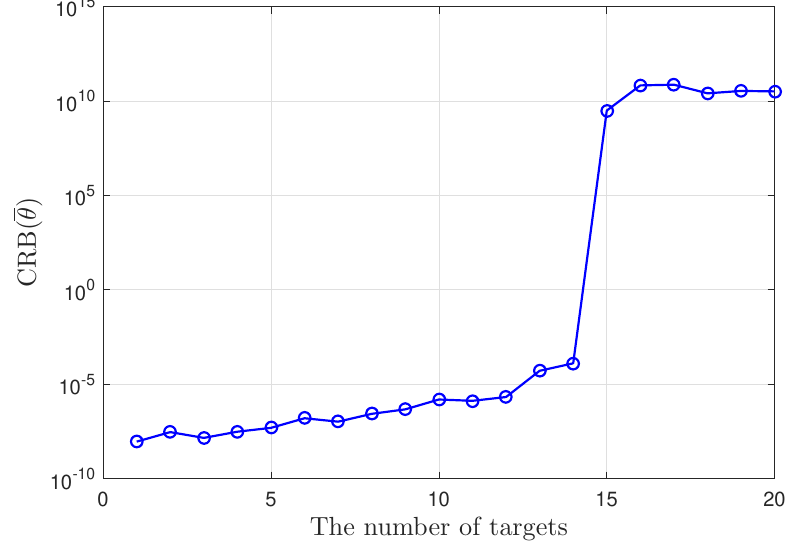
Figure 4. Cramér–Rao bound (CRB) for the normalized direction of arrivals (DOAs) of conventional sparse MIMO radar versus the number of targets.